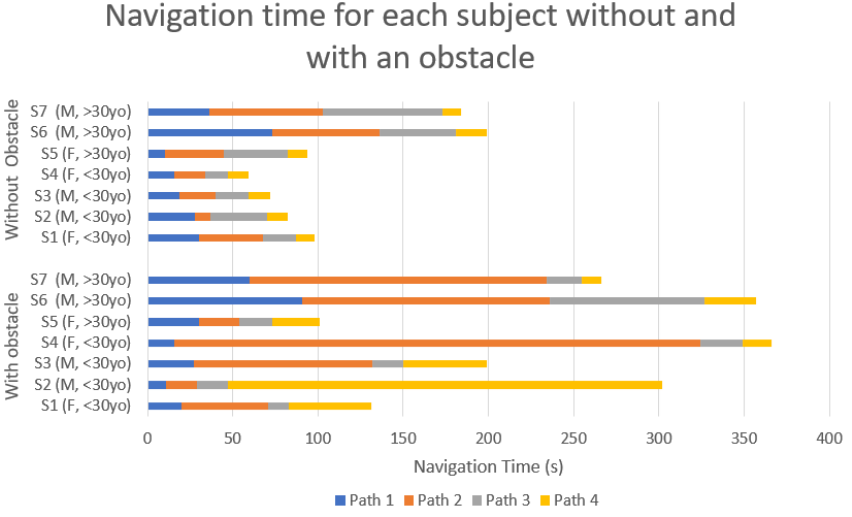
Figure 17. Navigation times from starting point to final point of each subject with and without an obstacle for four